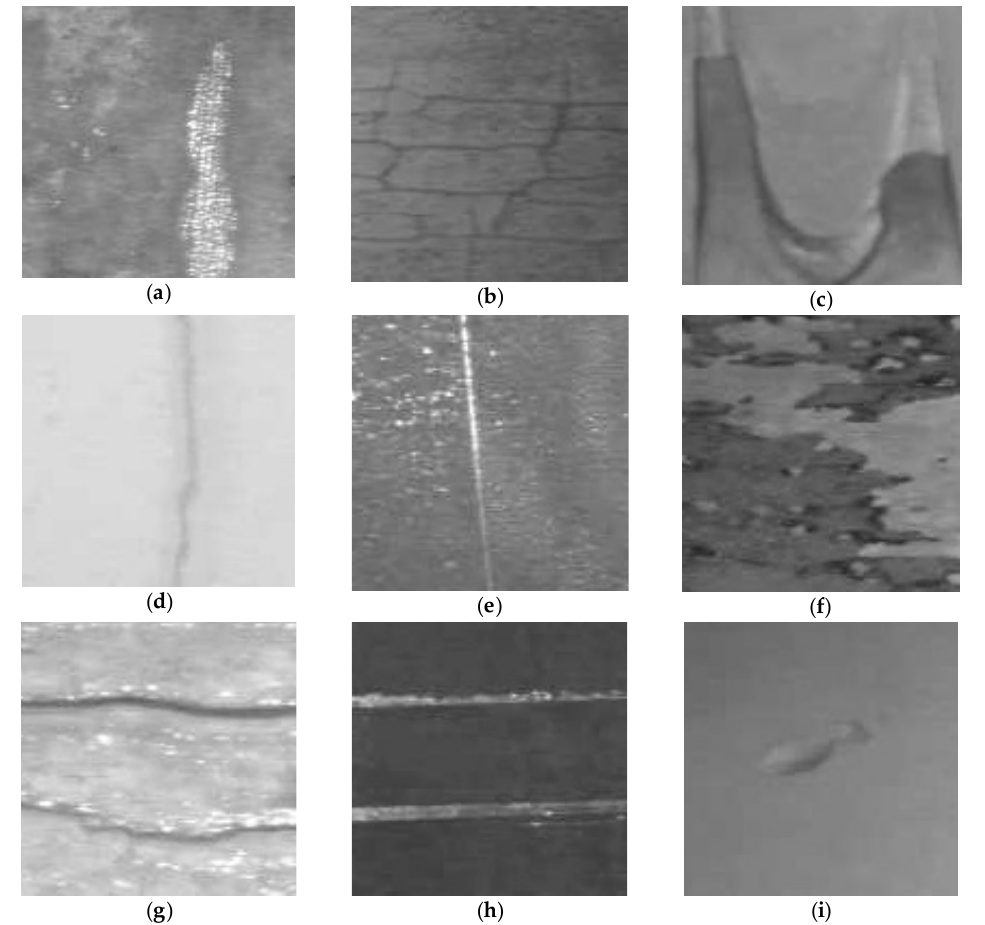
Figure 3. Nine kinds of typical defects of hot rolled steel plates: ( a ) pockmark; ( b ) chap; ( c ) scar; ( d ) longitudinal cracks; ( e ) longitudinal scratches; ( f ) scale; ( g ) transverse cracks; ( h ) transverse scratches; ( i ) roll mark.